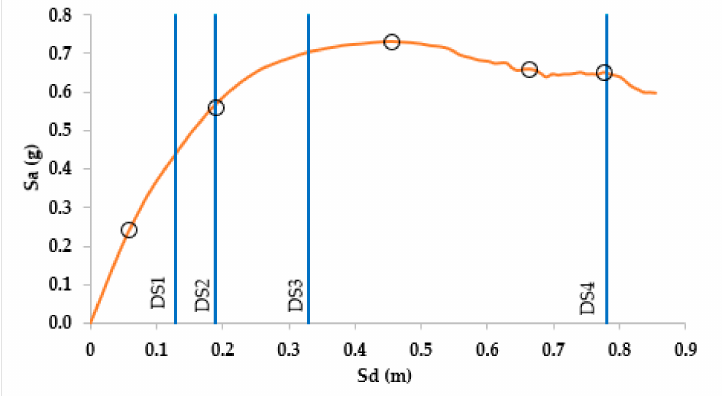
Figure 10. Damage limit state according to Equation